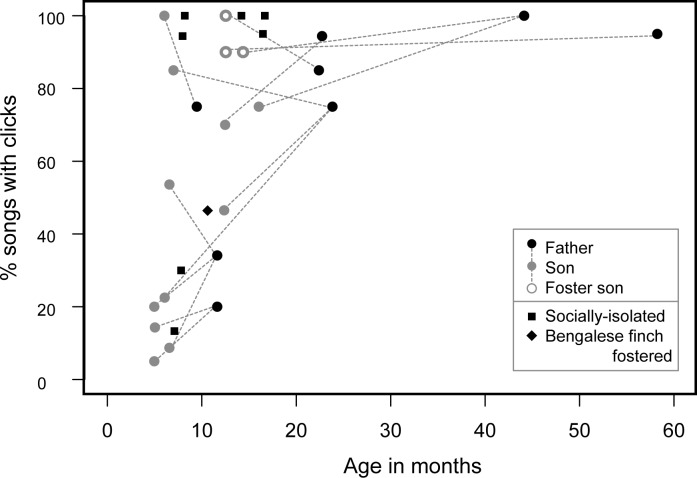
Age related increase in the rate of bill clicks.The proportion of songs with bill clicks in Java sparrow males from conspecific families (n = 22), untutored (n = 7), and heterospecific-fostered (n = 1) is shown as a function of the age of the individual. Fathers and sons are connected with dashed lines. The age effect was still significant when we reanalyzed the data excluding two outliers (the eldest two with frequent bill clicks).